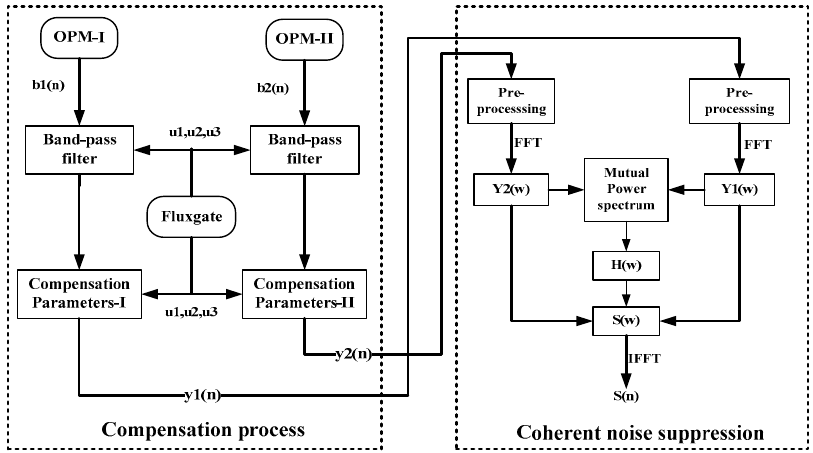
Figure 2. Block diagram of the aeromagnetic compensation and coherent noise suppression algorithm.